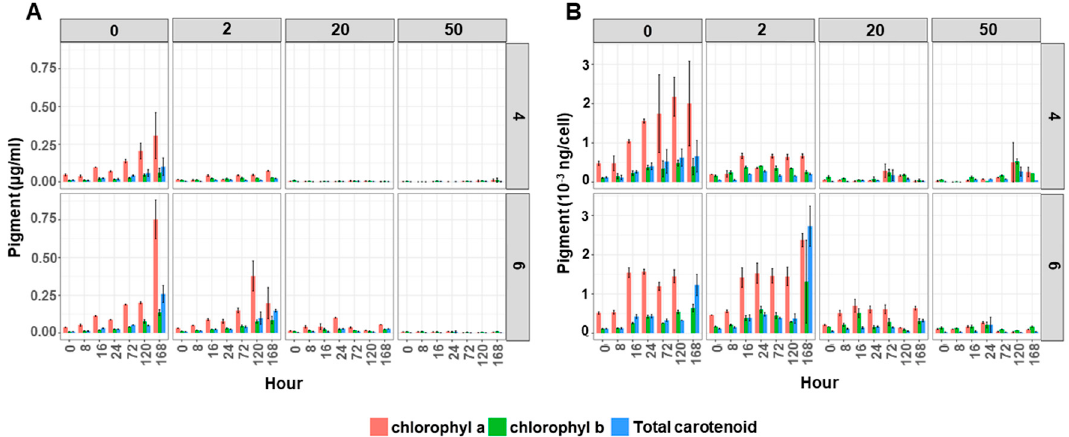
Figure 2. Pigment content (chlorophyll a (pink), chlorophyll b (green) and total carotenoids (blue)) of Desmodesmus sp. AARLG074 grown at pH 4 and pH 6 with varied copper concentrations (0, 2, 20, 50 mg / L) over 168 h. Data expressed as ( A ) pigments per volume of culture (ug per ml) and ( B ) per algal cell (ng per cell). Values are mean ± SD ( n = 3). 2.3. The Effects of Copper and pH on Metabolite Composition of Desmodesmus sp. AARLG074